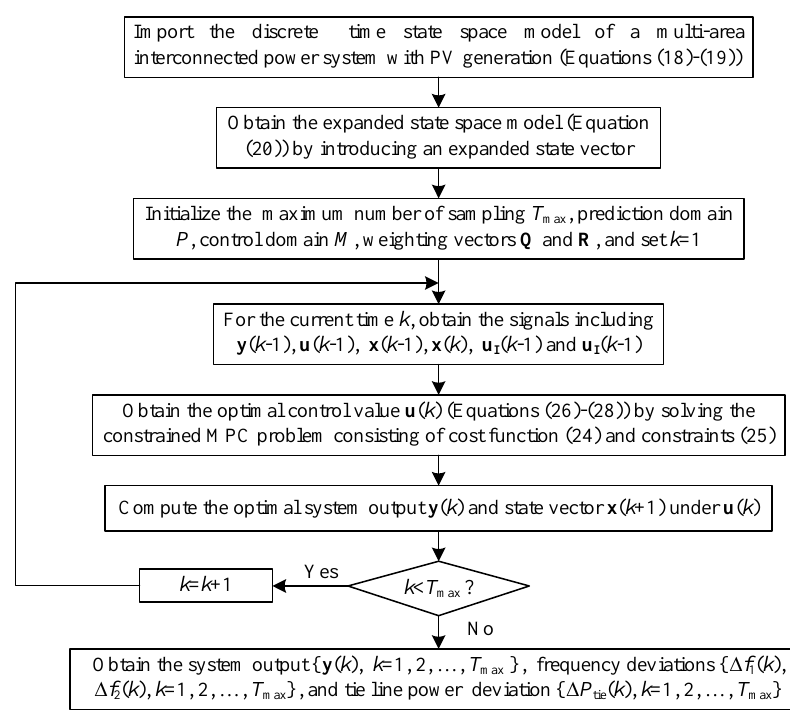
Figure 3. The flowchart of MPC for LFC of a multi-area interconnected power system with PV generation.